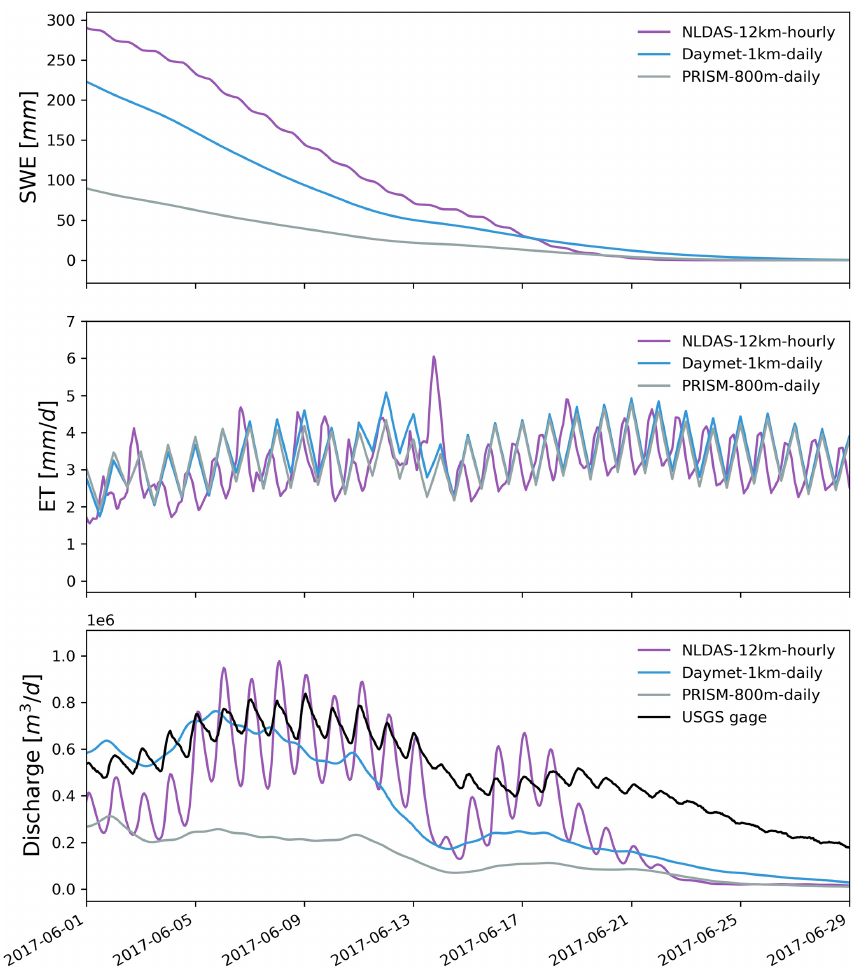
Figure 8. Zoomed-in plot showing simulated hourly watershed average SWE, ET, and discharge under different meteorological forcings from 1 to 29 June